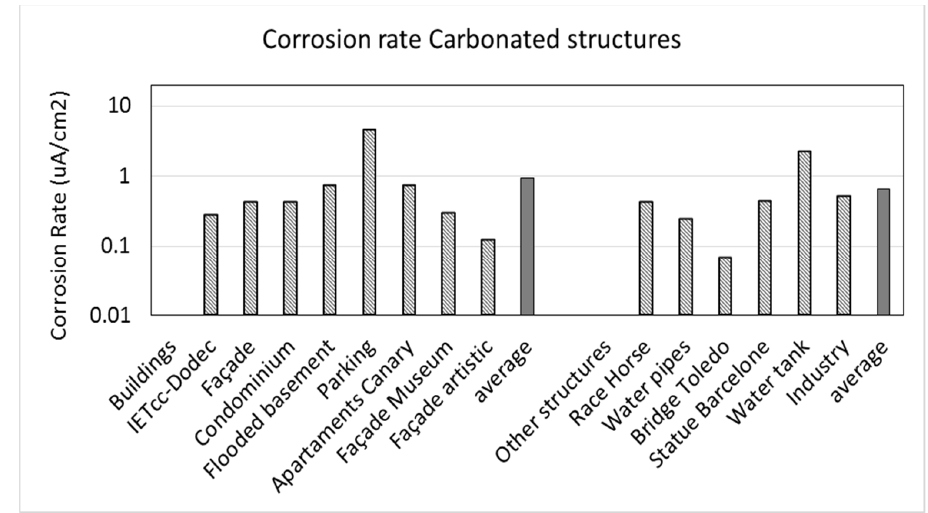
Figure 5. Average values of corrosion rate in different carbonated structures.